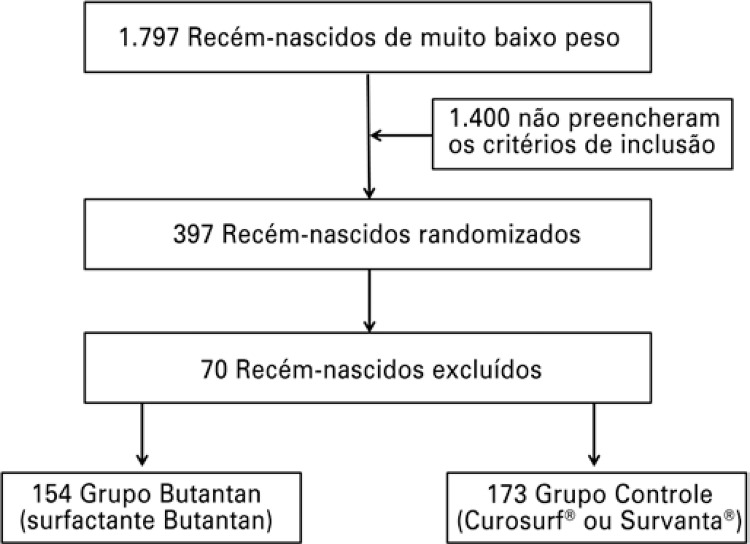
Fluxograma da seleção dos pacientes